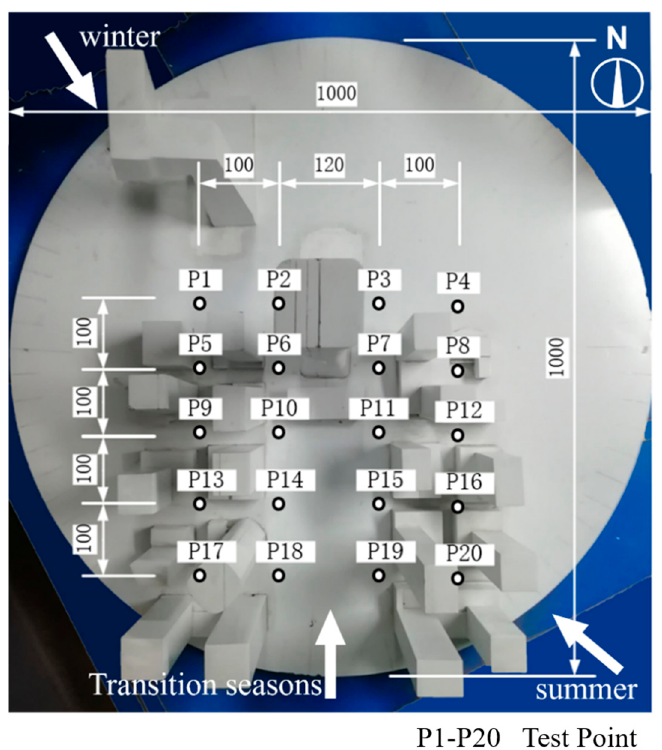
Figure 11. Building model and test points location (unit: mm).